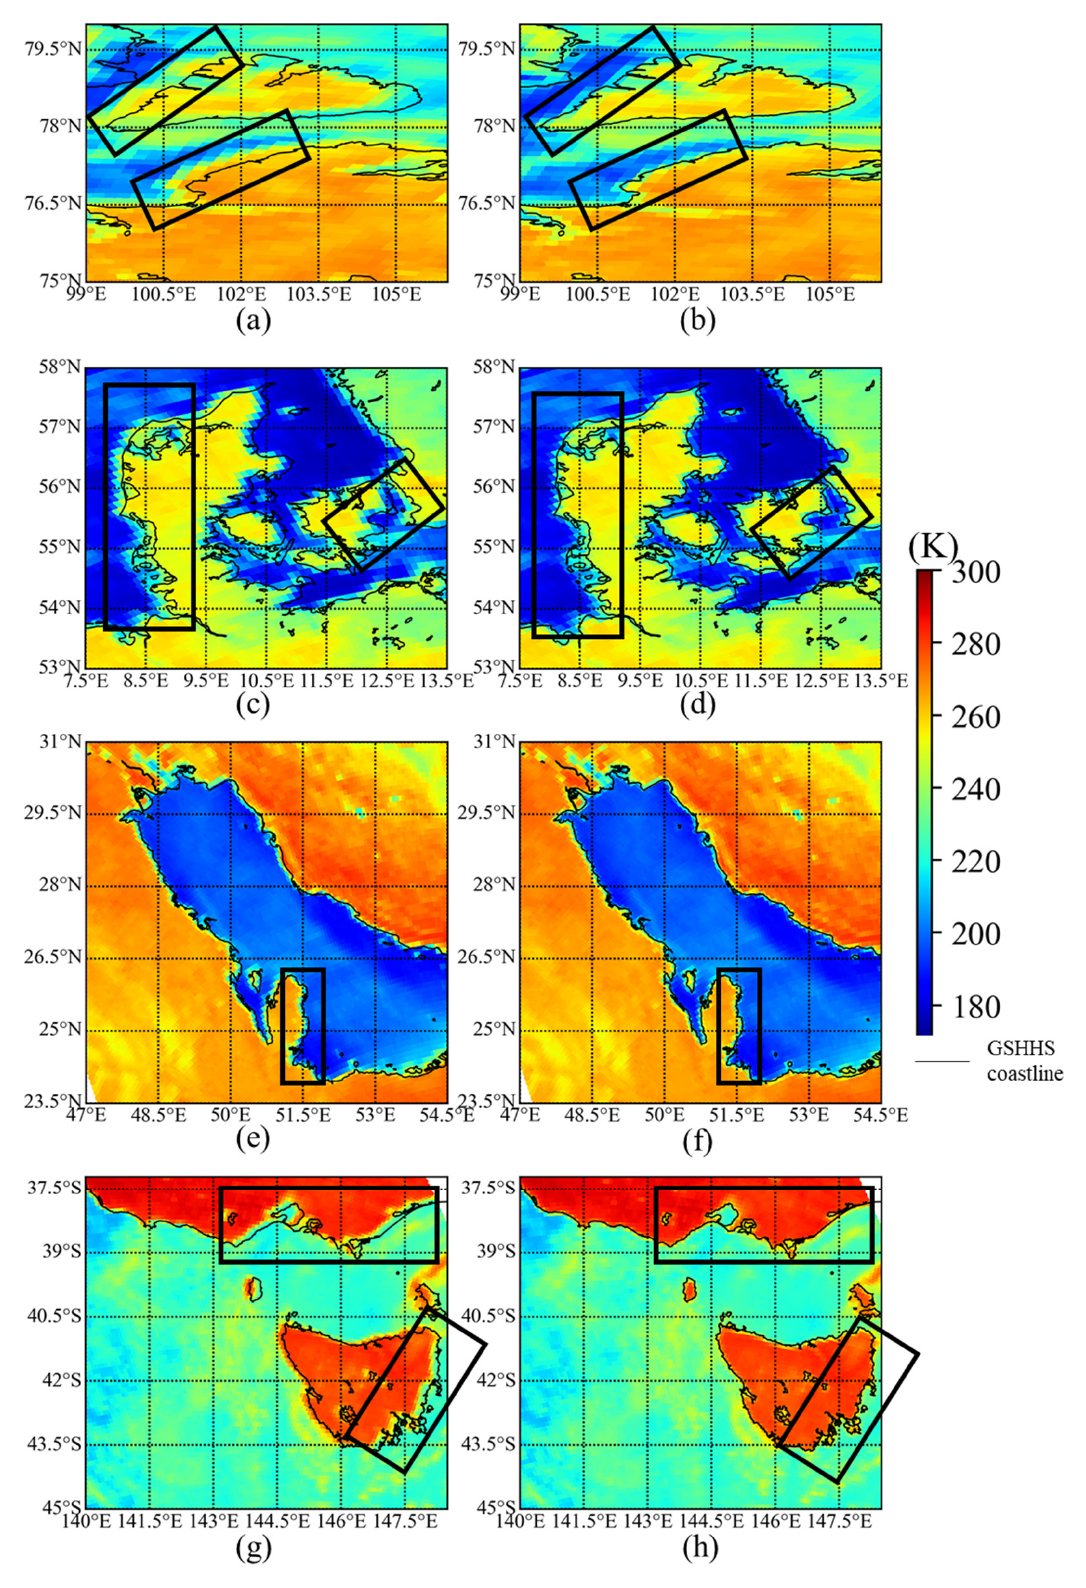
Figure 7. MWRI 89 GHz h-pol brightness temperature maps of four regions uncorrected ( a , c , e , g ) and corrected by SCIM ( b , d , f , h ). From top to bottom, the regions are Severnaya Zemlya ( a , b ), Denmark ( c , d ), the Persian Gulf ( e , f ), and Australia ( g , h ). The black boxes show the BT comparisons of some coastline regions between uncorrected and corrected FY ‐ 3D MWRI images